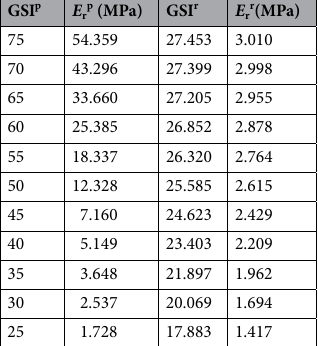
Table 3. Estimated values of E r p and E r r .